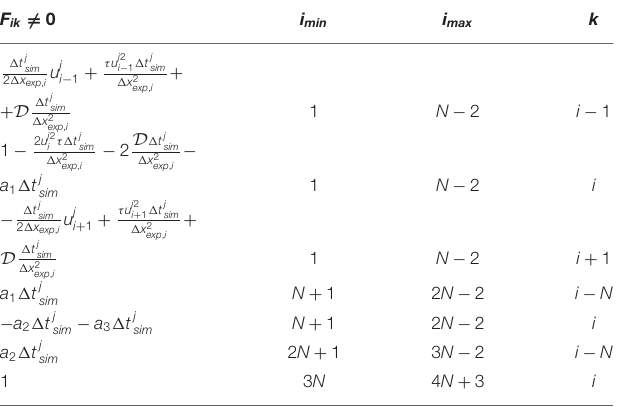
TABLE 2 | The Jacobian matrix V .